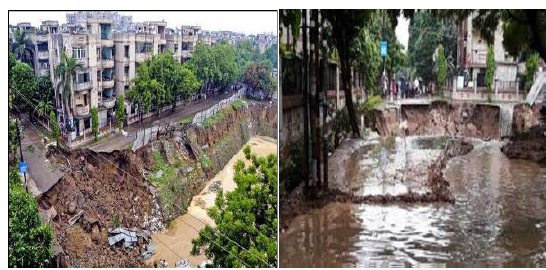
Figure 8 A road subsidence of Vasundra Ghaziabad photographs